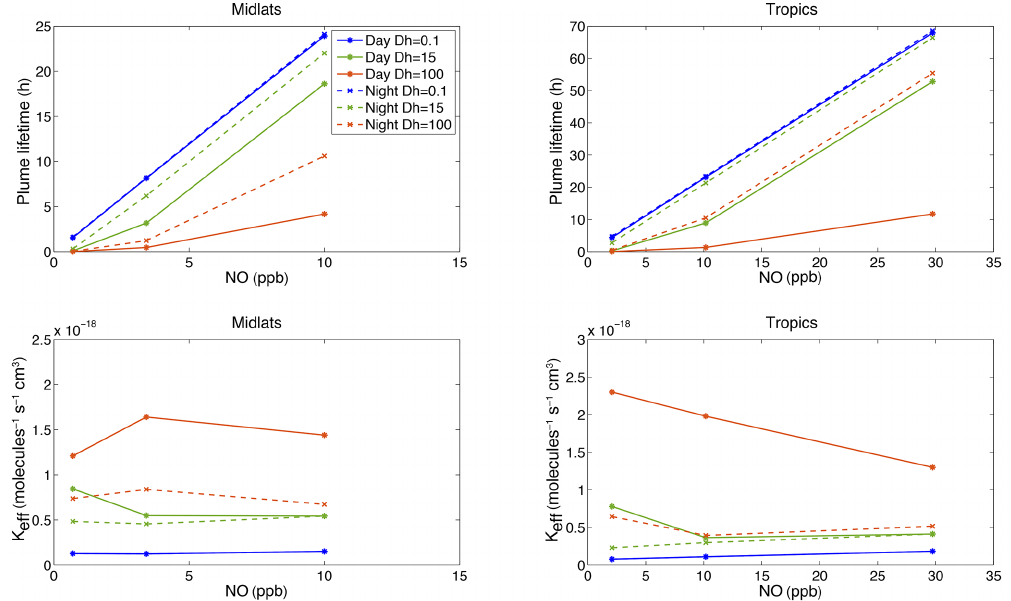
Figure 8. The plume lifetime ( τ , upper panels) and the effective reaction rate constant ( K eff , bottom panels) depending (i) on the horizontal coefficient diffusion ( D h , m 2 s − 1 ) for the midlatitudes (left panels) and the tropics (right panels) and (ii) on the NO mixing ratio injected by lightning (NO i , in